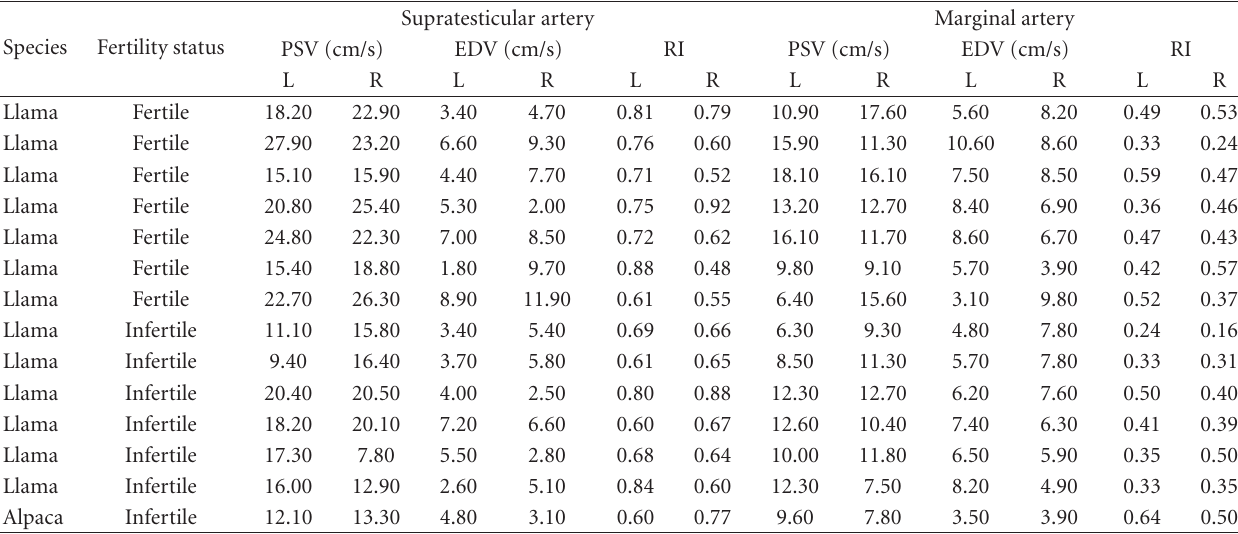
Table 2: Peak systolic velocity (PSV), end diastolic velocity (EDV), and resistance index (RI) for supratesticular and marginal arteries pulsatility from the left (L) and right (R) testes from fourteen camelids as determined using color pulsed-wave Doppler ultrasonography.